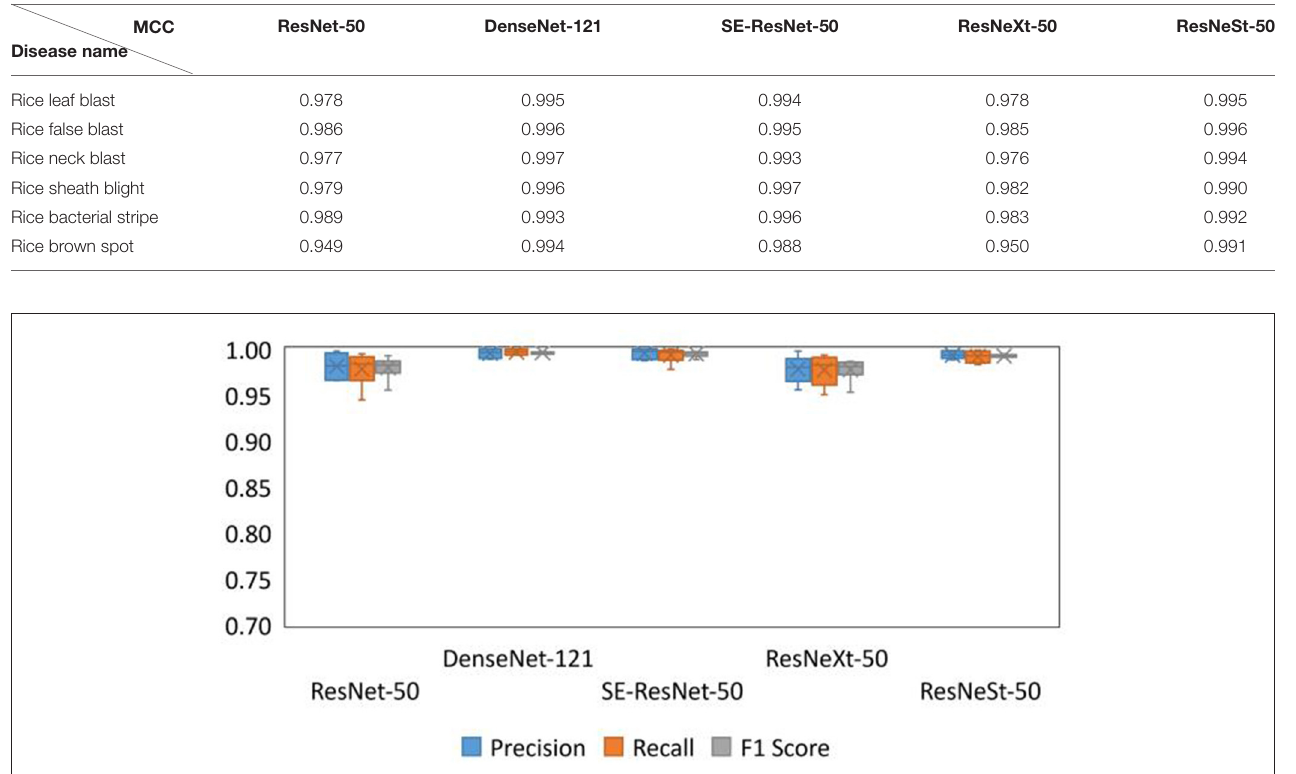
FIGURE 7 | Boxplots of precision, recall, and F1 score of the different submodels.